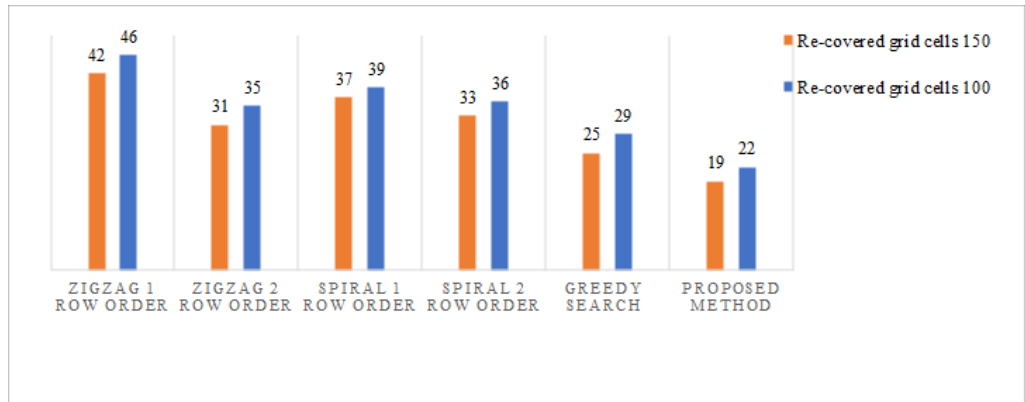
Figure 19. The area re-covered